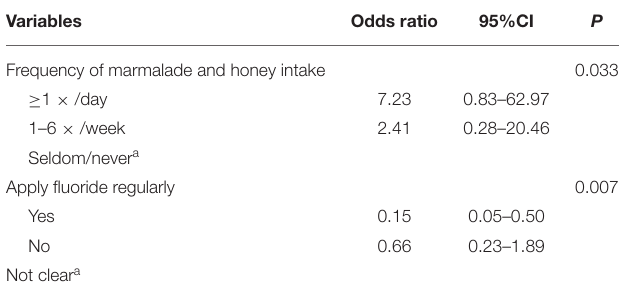
TABLE 1 | Application of multiple logistic regression model for black tooth